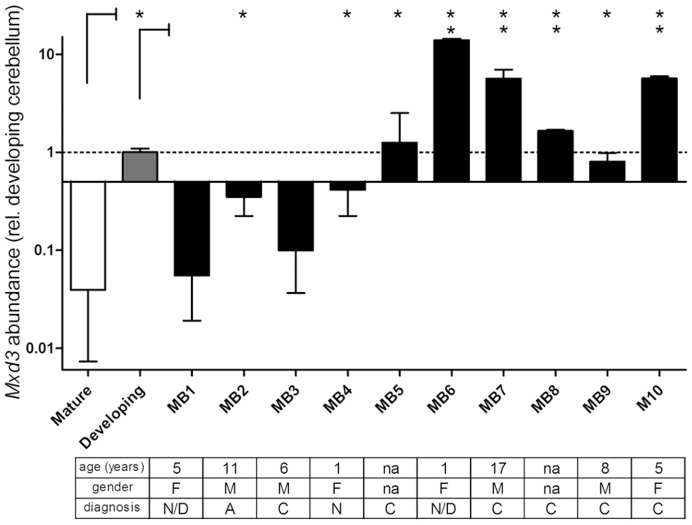
Expression of MXD3 in human medulloblastomas.
MXD3 mRNA levels in ten human medulloblastoma samples, normal developing and normal mature cerebellum determined by quantitative RT-PCR analysis. Values represent the mean fold-difference in mRNA (n  = 4) relative to developing cerebellum. Error bars indicate standard deviation (SD). Note the logarithmic scale of the Y-axis. The developing cerebellum sample and eight out of ten medulloblastomas showed significantly higher expression of MXD3 when compared to normal mature tissue (asterisks, p<0.01; one-way ANOVA).